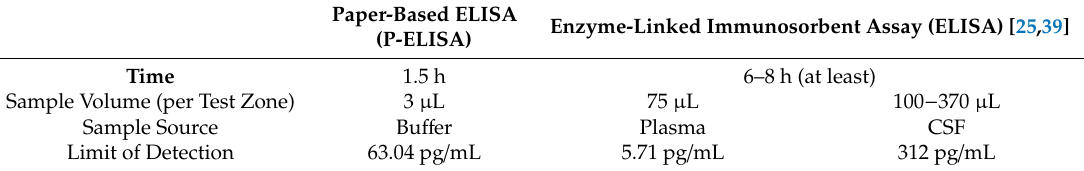
Figure 3. The role of point-of-care (POC) β -amyloid peptide 1–42 (A β 42) testing for patients with preclinical Alzheimer’s disease (AD), amnestic mild cognitive impairment (MCI) due to AD, and AD dementia. Table 2. Comparison between the paper-based ELISA (P-ELISA) and conventional enzyme-linked immunosorbent assay (ELISA) systems for the detection of β -amyloid peptide 1–42 (A β 42) using plasma and cerebrospinal fluid (CSF)